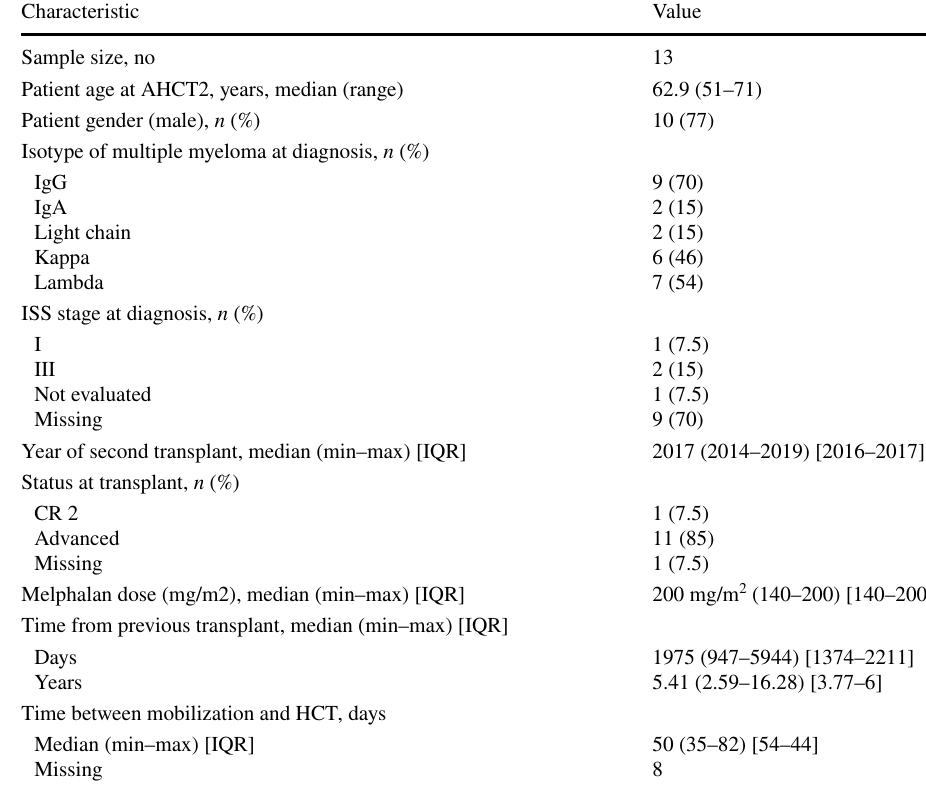
Table 1 Patient and transplant characteristics ( n = 13)